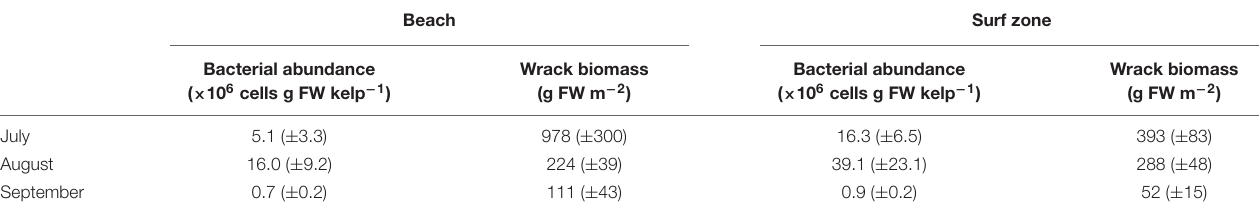
TABLE 3 | Average ( ± SE) bacterial abundance on kelp ( Ecklonia radiata ) and kelp biomass on the beach and in the surf zone over three times when wrack is abundant in sandy beach ecosystems in south-western